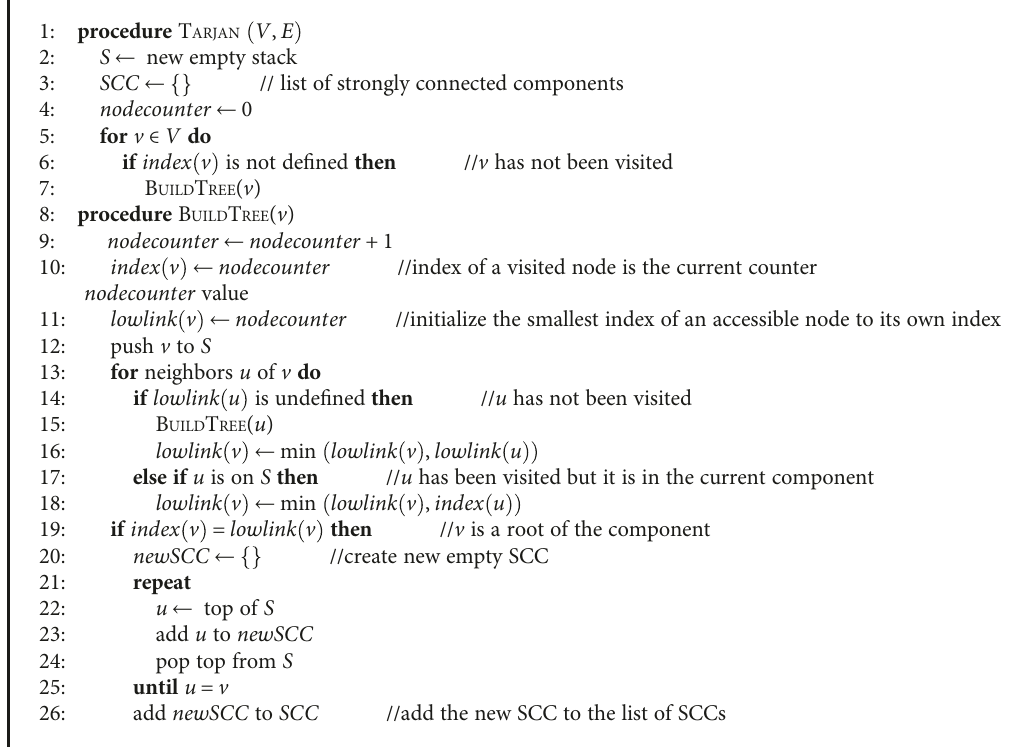
Algorithm 1. Tarjan ’ s Strongly Connected Component Algorithm.